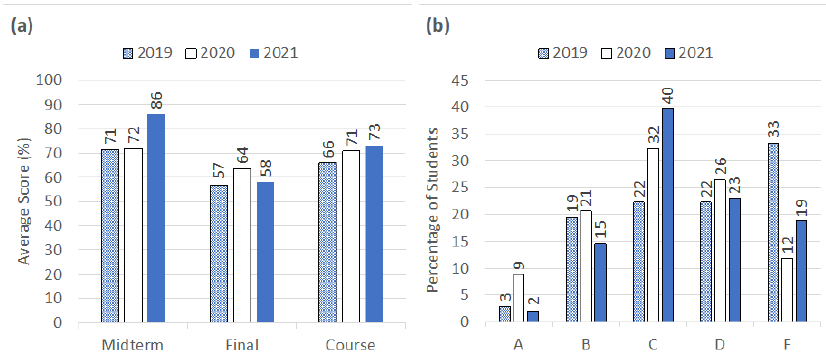
Fig. 2. (a) Average score of the students in the midterm and final exams and the final course grade. (b) Distribution of grades in the final